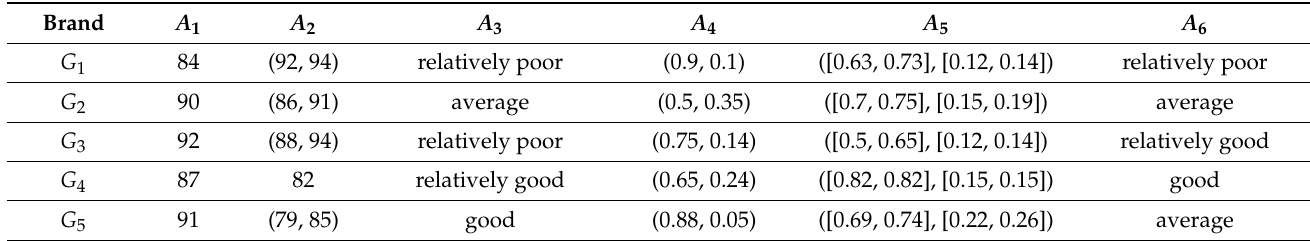
Table 5. The evaluation matrix of expert D 3 .